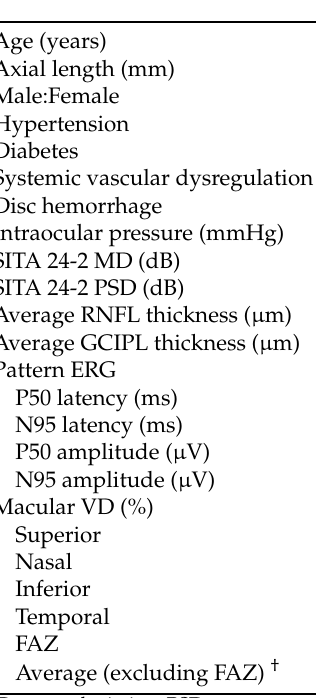
Table 1. Baseline characteristics of study subjects ( n =